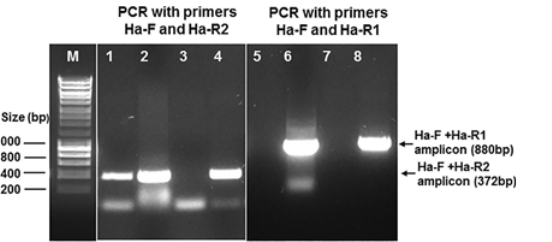
Fig 3. PCR primer optimization and amplification of the fliC-a gene of S . Paratyphi A. Lanes: M, DNA marker; 1 and 5, blood DNA only; 2 and 6, blood DNA spiked with S . Paratyphi A DNA; 3 and 7, no DNA negative control; 4 and 8, S . Paratyphi A DNA positive